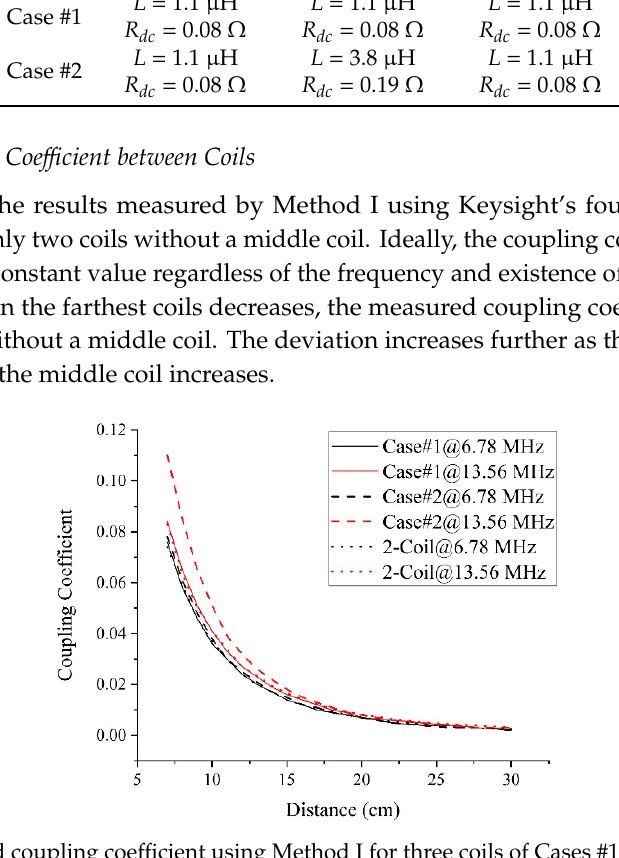
Figure 6. Measured coupling coefficient using Method I for three coils of Cases #1, #2, and two coils.